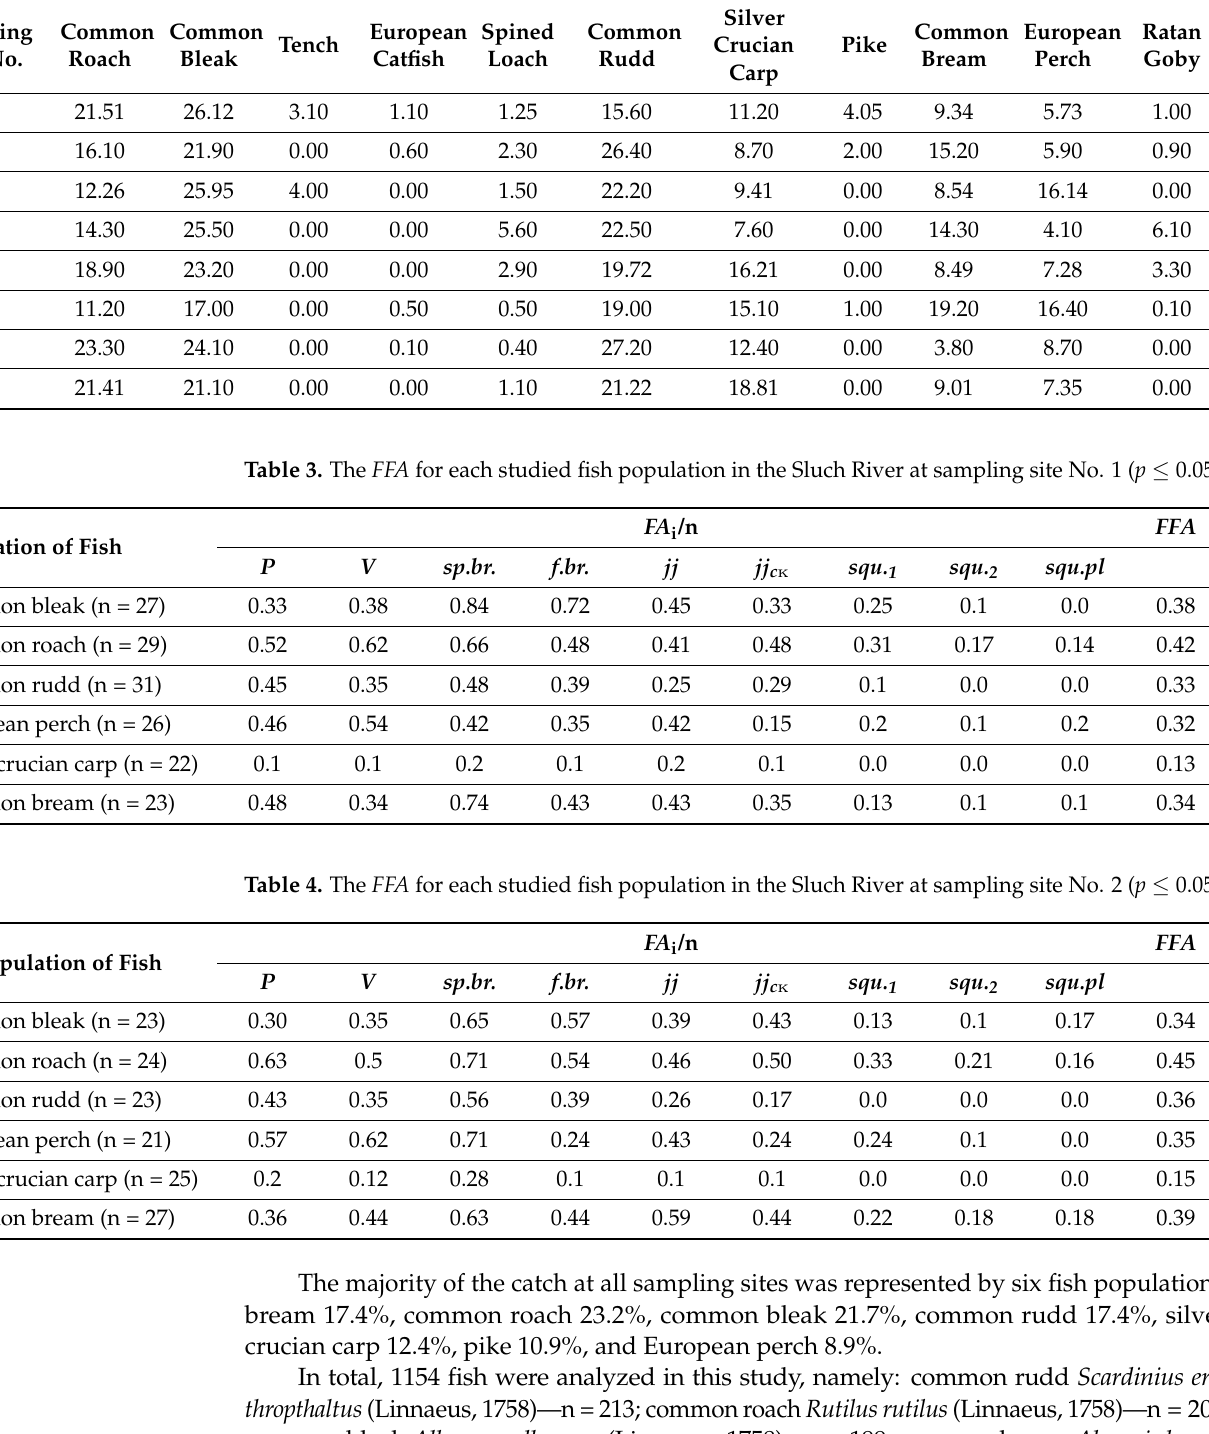
Table 2. The ratio of detected fish populations in sampling sites according to catches using recreational fishing methods.